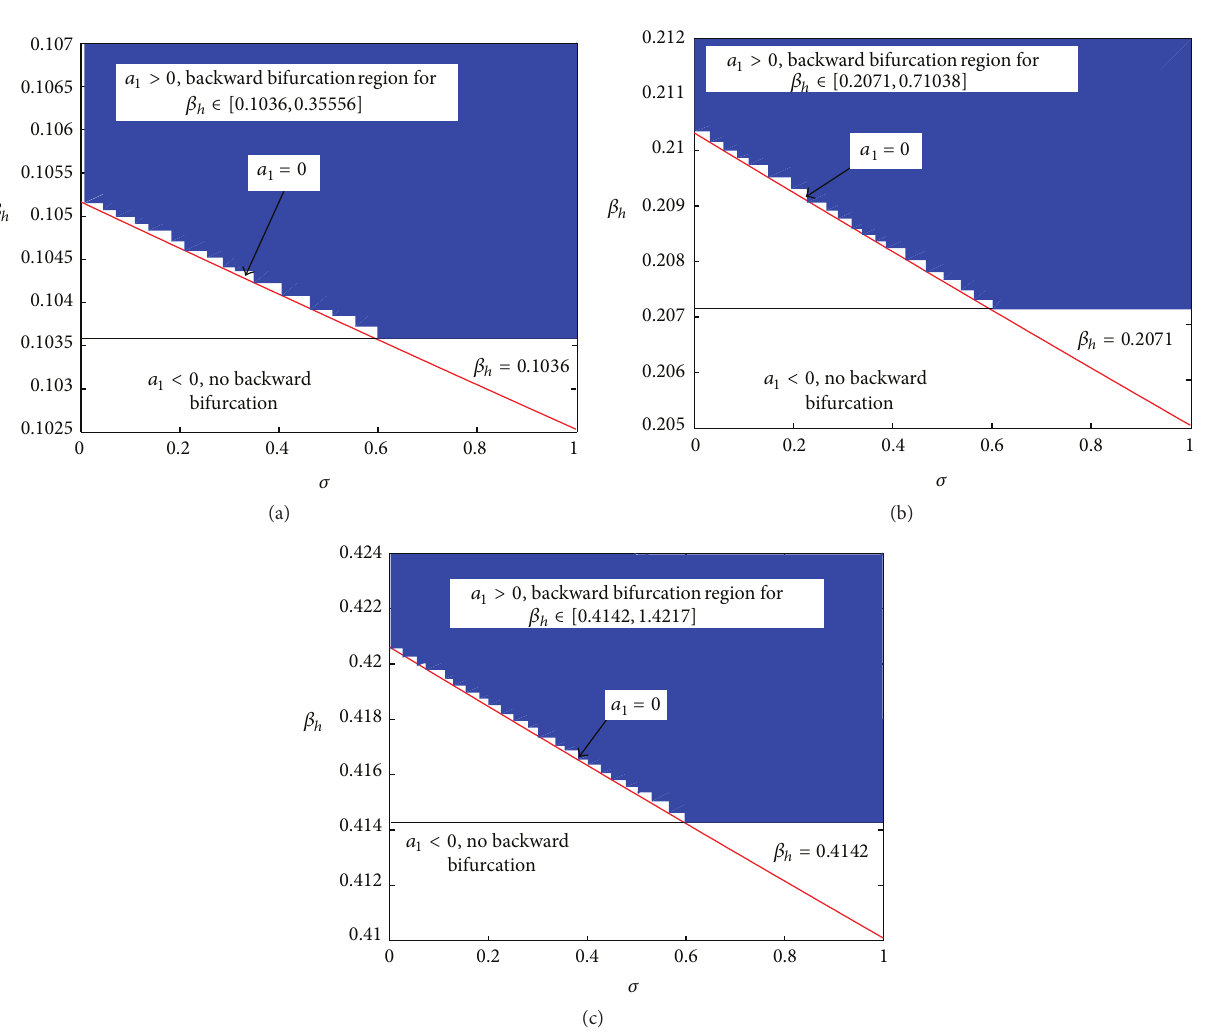
𝛽 ∈ [0.1036, 0.35556]) , (b) 𝜇 = 0.1, ℜ = 0.00035113 (backward bifurcation region for 𝛽 ℎ is ℎ 𝑣 0